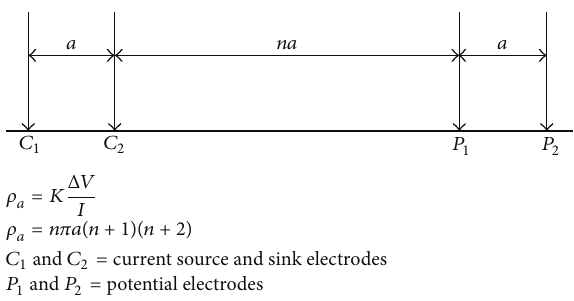
Figure 3: Typical dipole-dipole electrode configuration for the electrical resistivity method (Redrawn after Loke, 2000